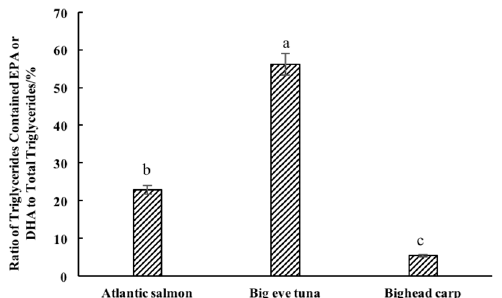
Figure 5. Ratio of triglyceride (TG) molecules contained EPA or DHA to total TG molecules. a–c means significant difference, p < 0.05.